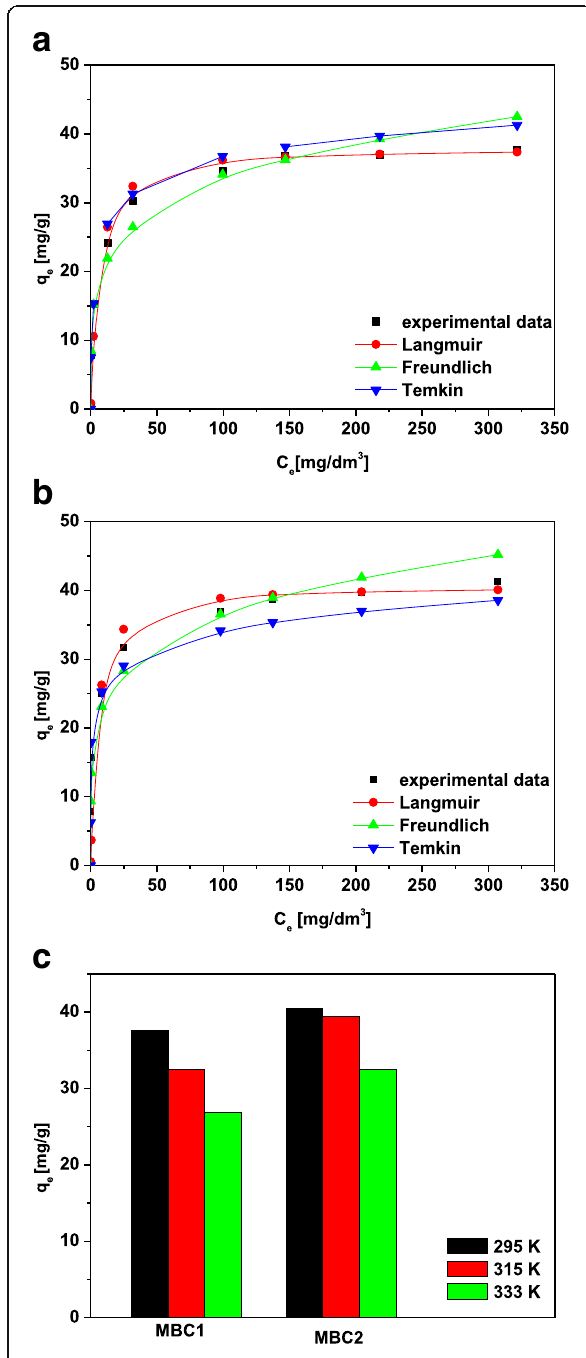
Fig. 3 Isotherm data and fitted models for Cd(II) sorption on a MBC1 and b MBC2 and c effect of temperature on Cd(II) sorption on MBC1 and